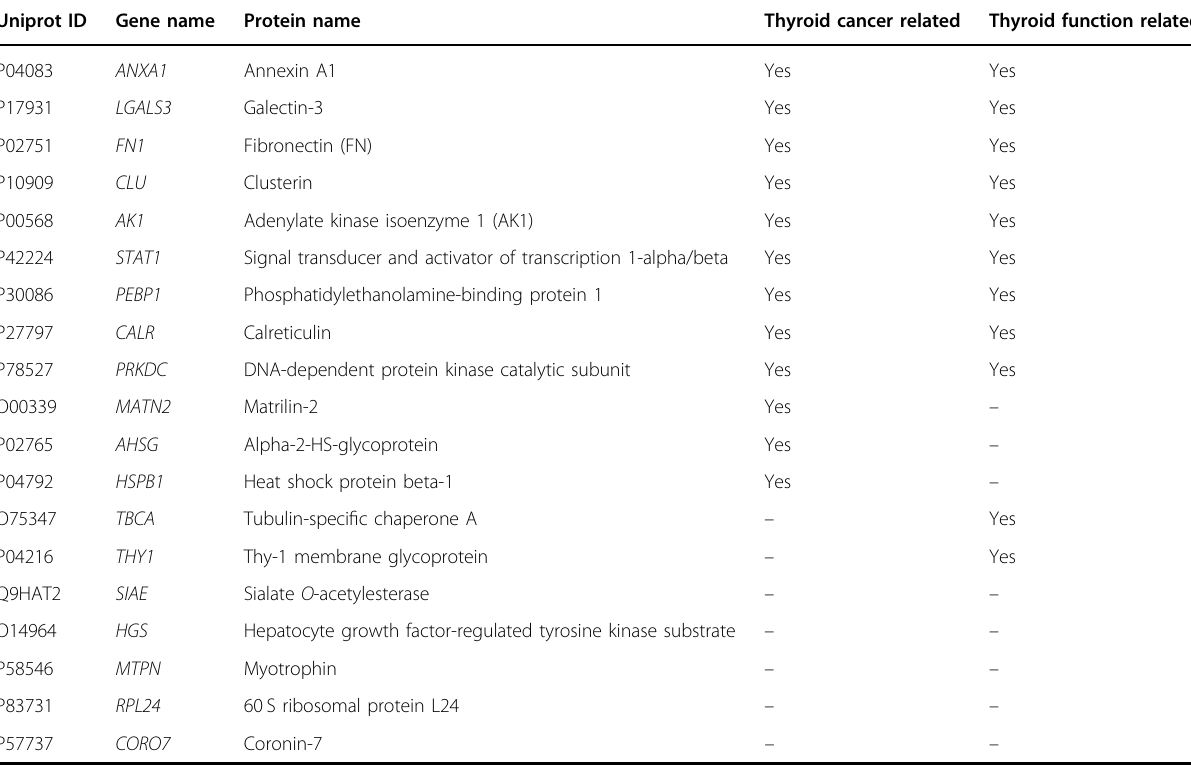
Table 1 Nineteen proteins selected by genetic algorithm and previously known associations with thyroid physiology or